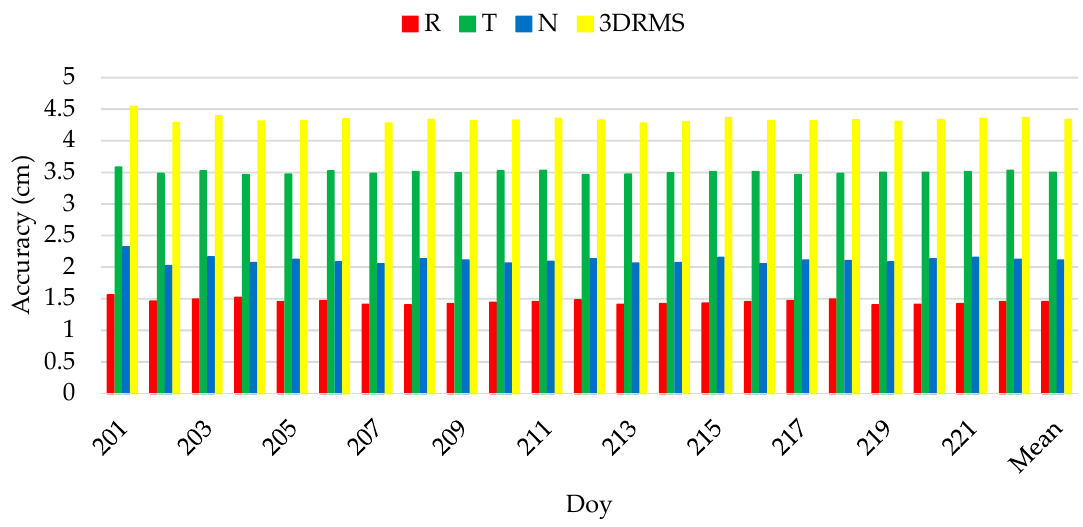
Figure 9. The RMS values for HY2D satellite using spaceborne GPS data.